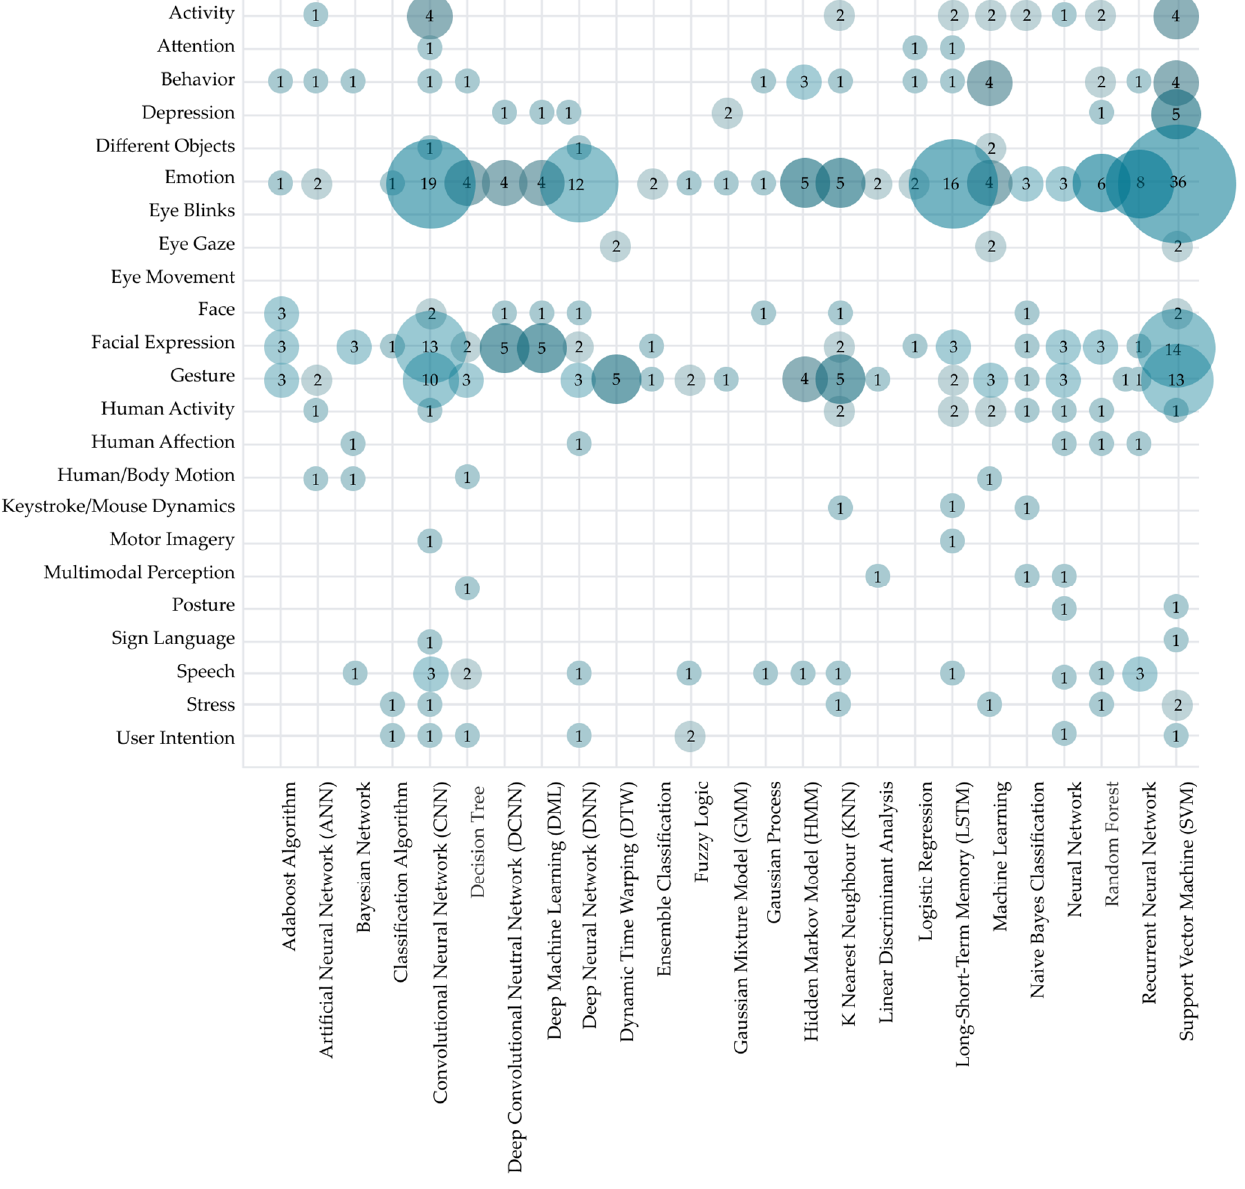
Figure 20. Distribution of AI methods and algorithms used for HCI recognition solutions.